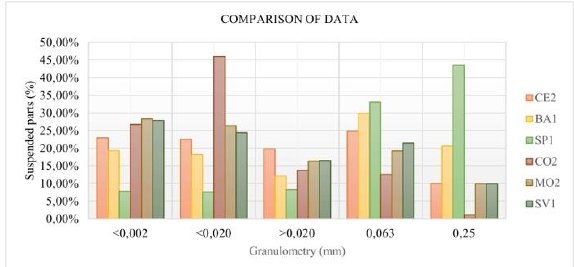
Figure 8. Roero soils grain size distribution comparison Data, reworking of the